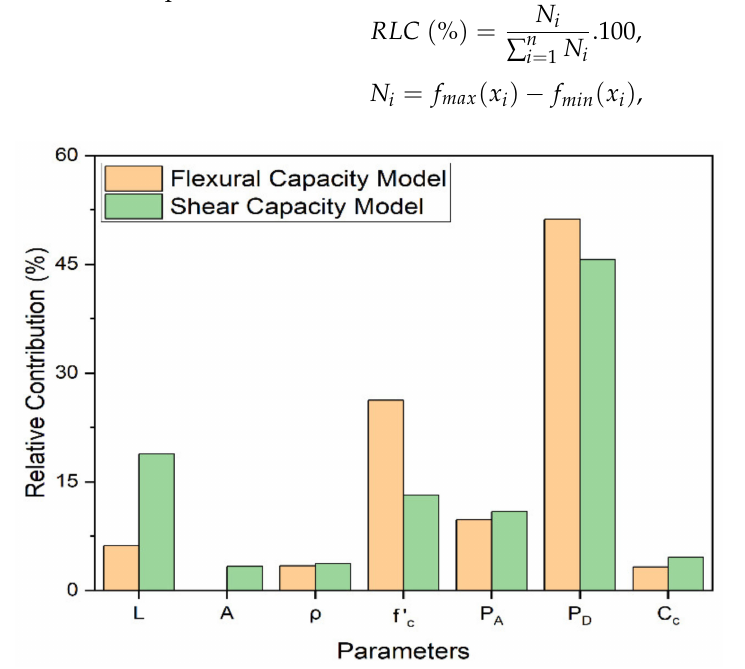
Figure 5. Relative Contribution of Input Parameters to the Model